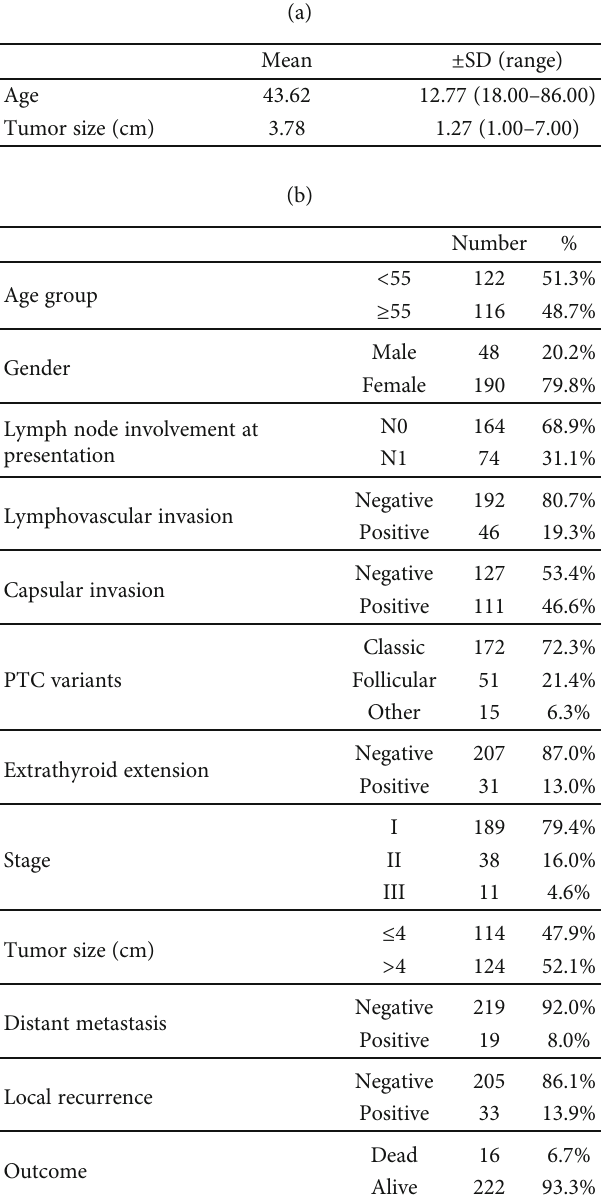
Table 1: Clinicopathological characteristics of PTC